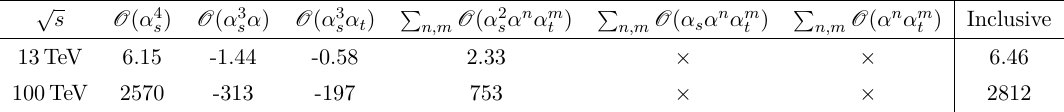
Table 1 . Entries in each column correspond to the LO t ¯ tt ¯ t SM cross-section [fb] in line of α s order, √ √ at the LHC ( s = 13 ) and FCC-hh ( s = 100 ). For contributions at O ( α N ) with N = 0 − 2 , we s sum all possible weak and Yukawa coupling combinations and present the total cross-section at a given order in α s . The notation “ × ” denotes negligible contributions. The column titled “Inclusive” shows the total